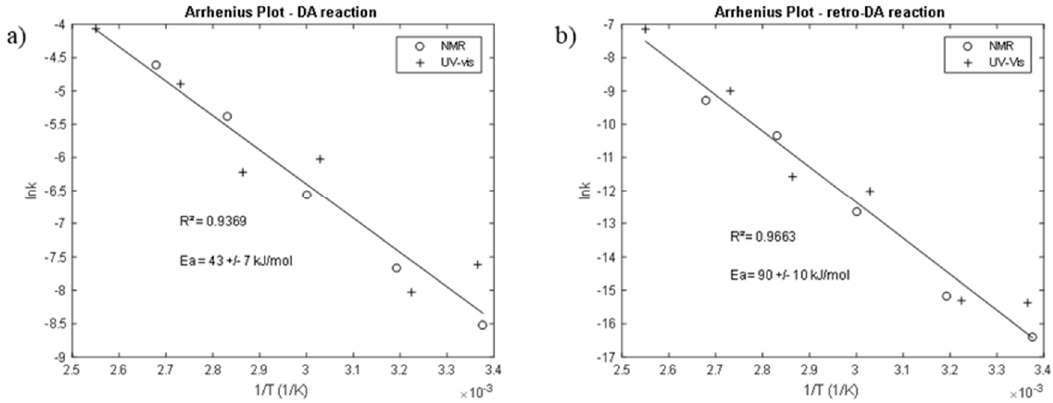
Figure 3. Arrhenius plot for FAL–NHM reaction: ( a ) Forward reaction and ( b ) reverse reaction.